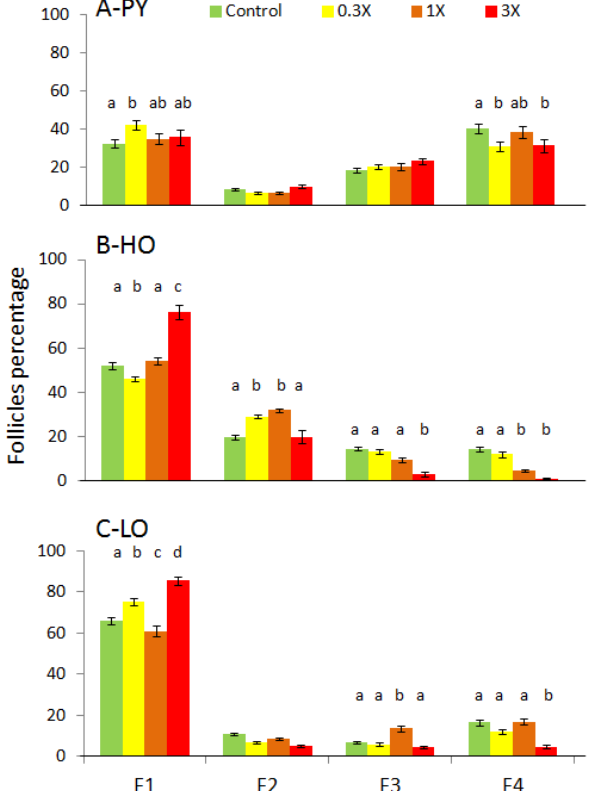
Figure 6. Follicles distribution according to their stage. Follicles were classified according to their maturation: pre-vitellogenic stages (F1 and F2); post-vitellogenic stage (F3) and mature follicles (F4). Percentage of follicles in each class, mean ± SEM. Different letters indicate significant difference compared to the relative control ( p < 0.05).